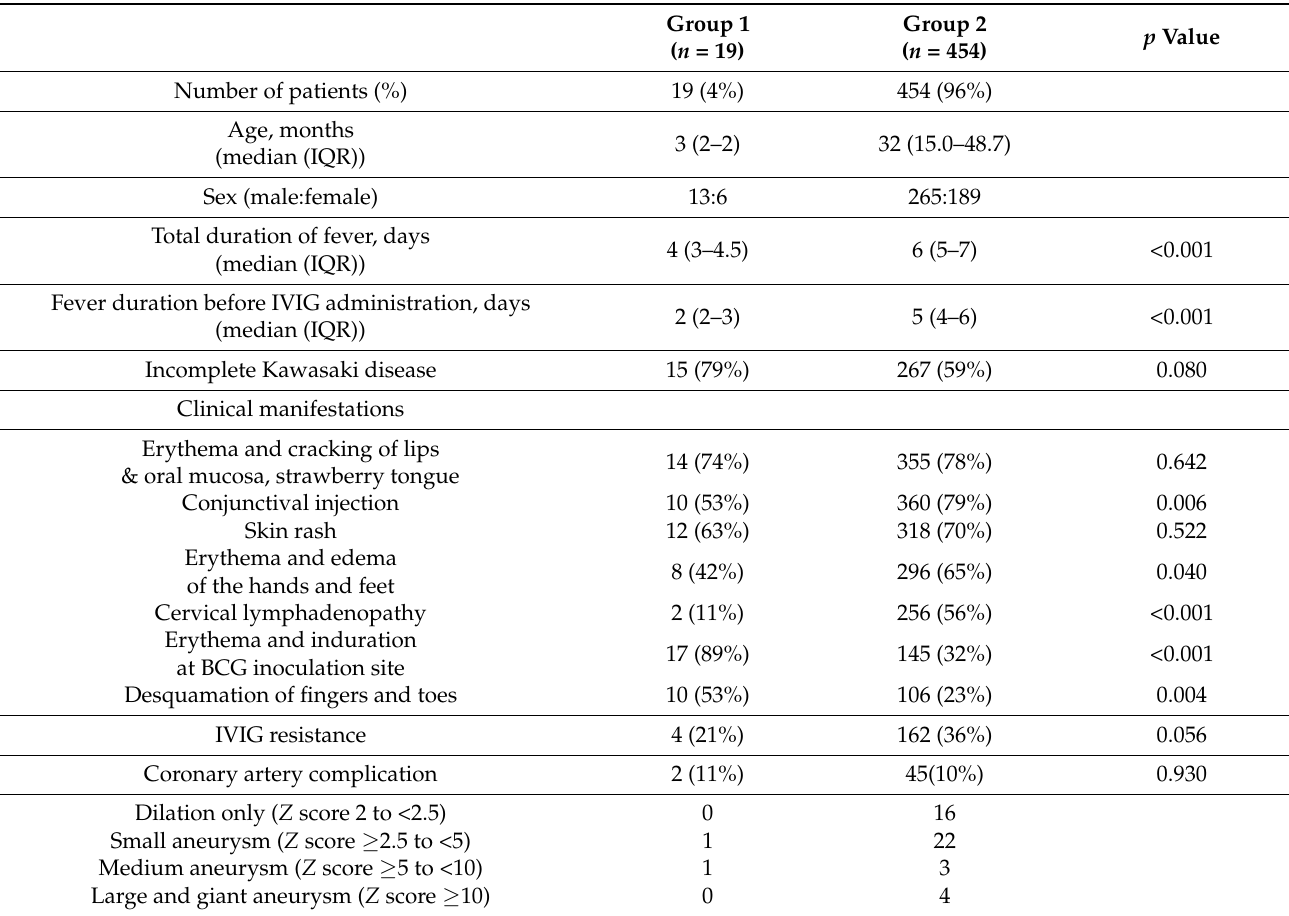
Table 1. Comparison of demographic and clinical characteristics between